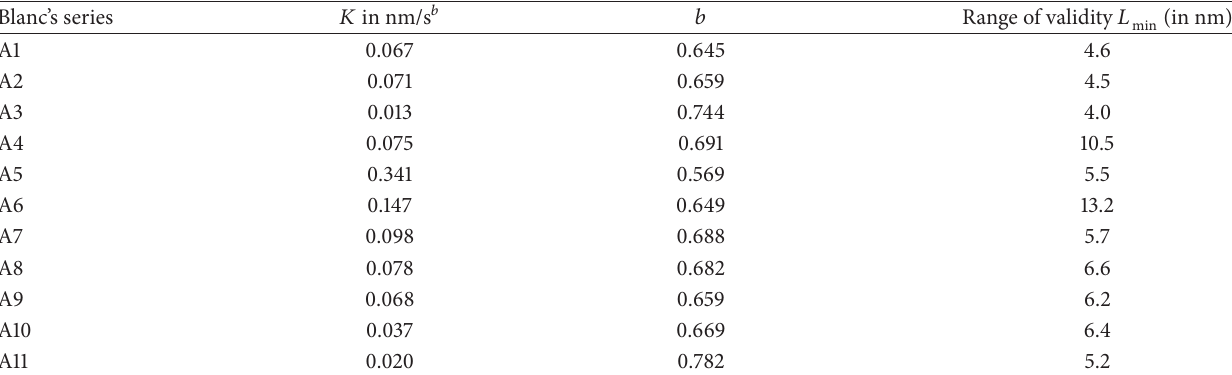
Table 2: Values of 𝐾 and 𝑏 in (36), calculated from the data in [6]. 𝐿 min is the minimum silicon oxide thickness where (36) holds. Blanc’s